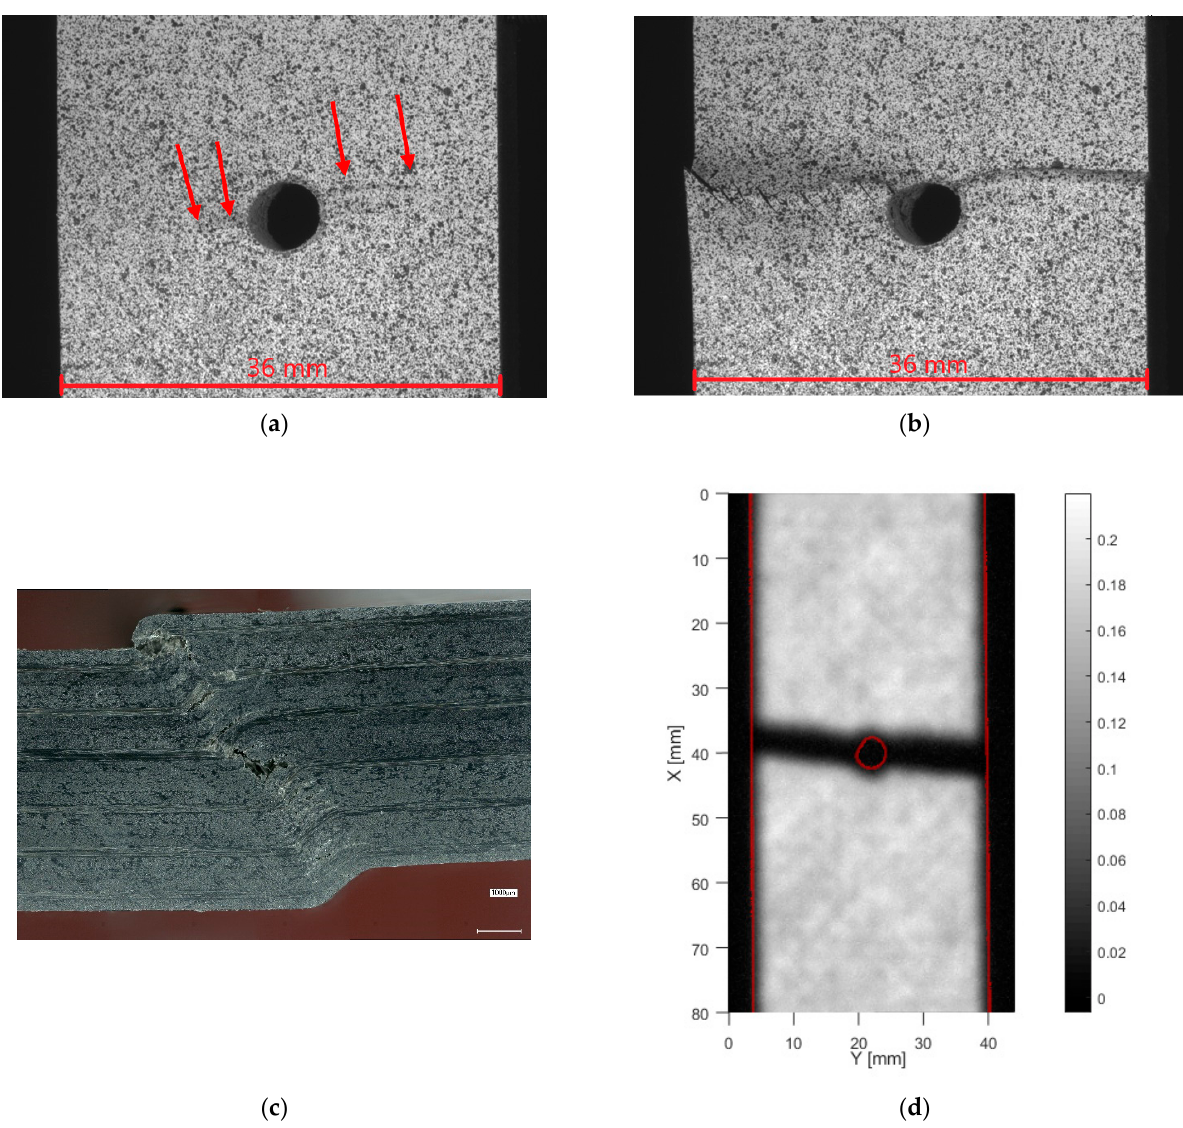
Figure 10. Compressive failure of [+45/0/ − 45/90] 3s , ( a ) front view just before failure, ( b ) front view after kinking failure, ( c ) side microscopy, ( d ) through transmission ultrasound (for high resolution, please refer to the online version of this article) .